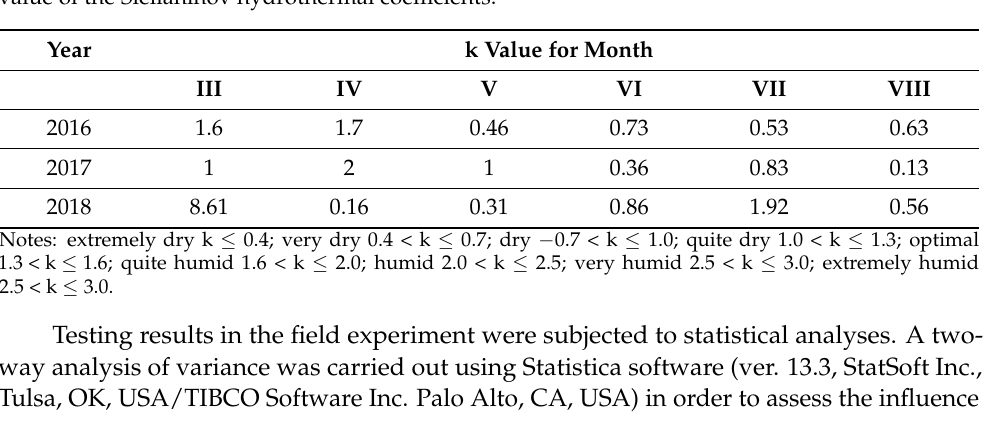
Table 3. Moisture characteristics of the months of the growing season (2016–2018) depending on the value of the Sielianinov hydrothermal